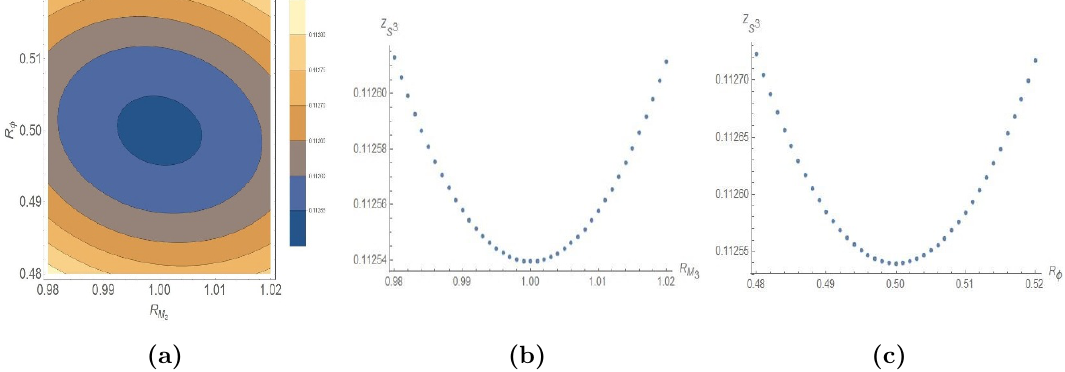
vs. r M at r (cid:30) = 1 . (c) Plot S 3 2 3